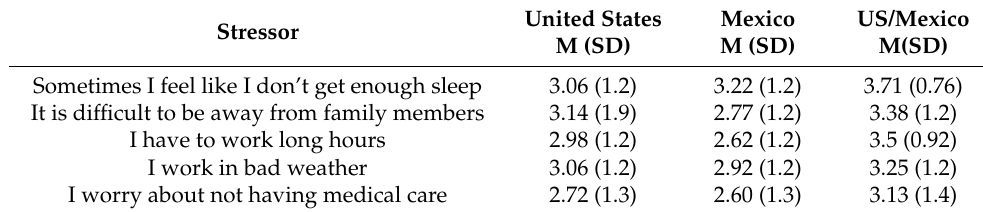
Table 3. Top five stressors by nighttime